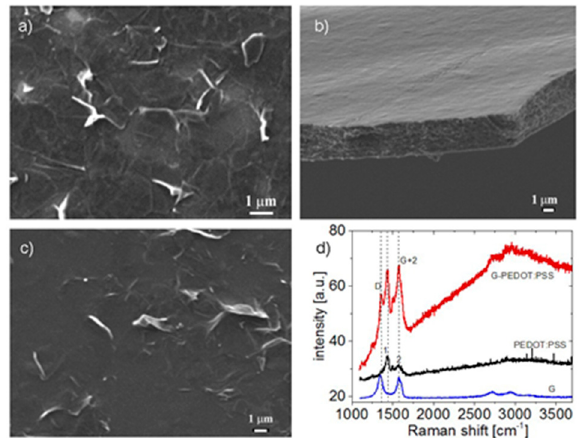
Figure 1. SEM images of the surface of the films printed from a suspension of graphene ( a ), PEDOT: PSS ( b ), and C1a1 composite ( c ) on the surface of SiO 2 / Si substrates. Raman spectra of graphene, PEDOT: PSS, and C1a1 composite films printed on SiO 2 / Si substrates ( d ).